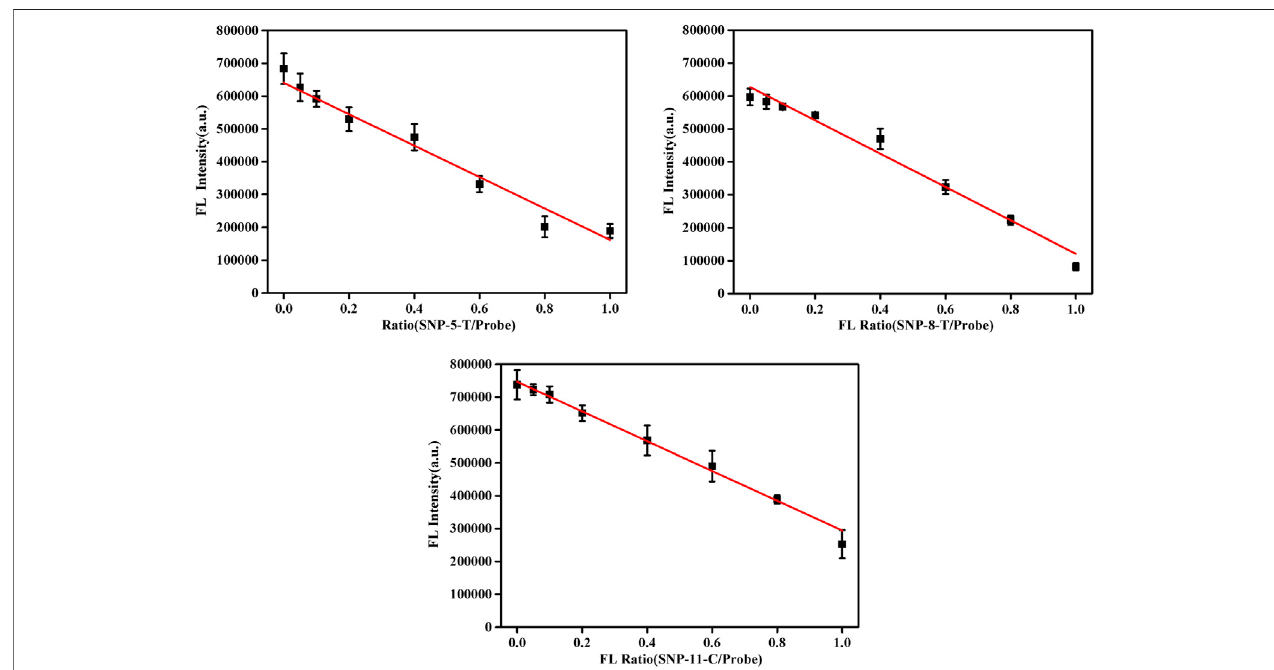
FIGURE 5 | Fluorescence spectra in the presence of different allele frequency [pcDNA/(pcDNA + smDNA) was 0, 5, 10, 20, 40, 60, 80, and 100%, and the total target DNA containing pcDNA and smDNA was 20 nM]. Other conditions were same as Figure 1 .